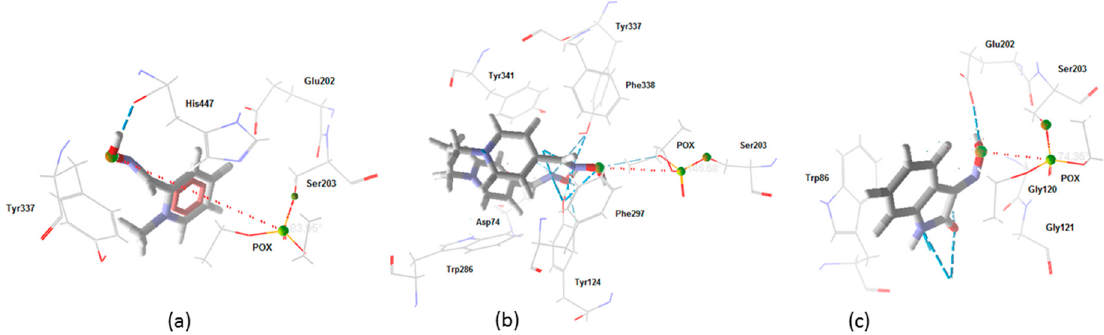
Figure 6. Best docking poses for: ( a ) 2-PAM; ( b ) obidoxime; and ( c ) isatin-O.